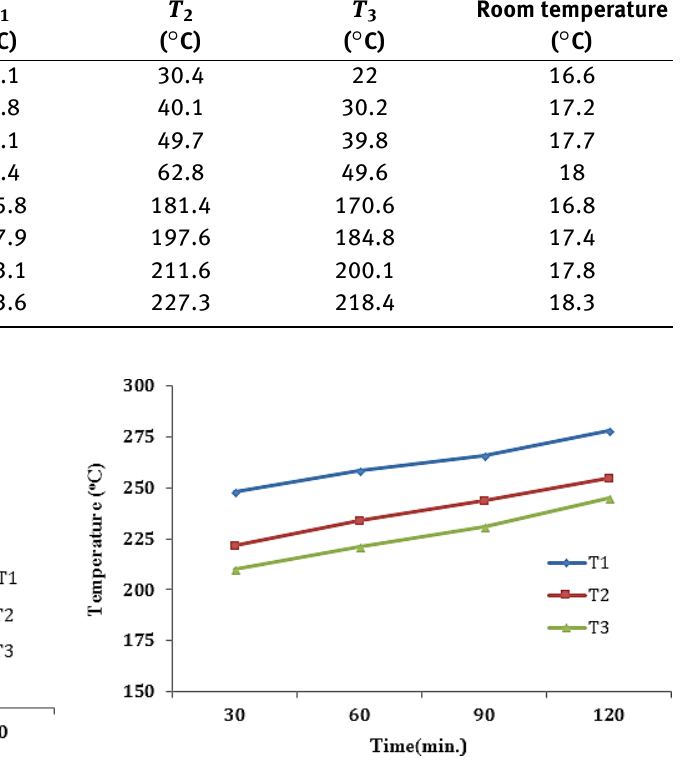
Figure 4: The temperature distribution of uncoated specimen at a constant source temperature of 100 ∘ C